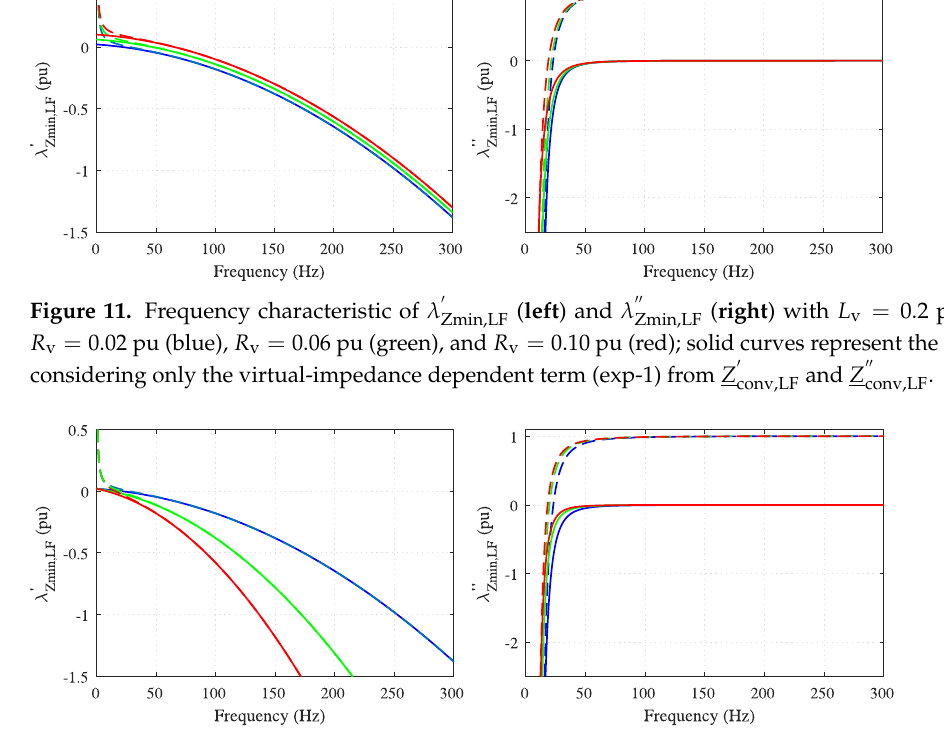
( left ) and λ (cid:48)(cid:48) ( right ) with R v = 0.02 pu and Zmin,LF Zmin,LF